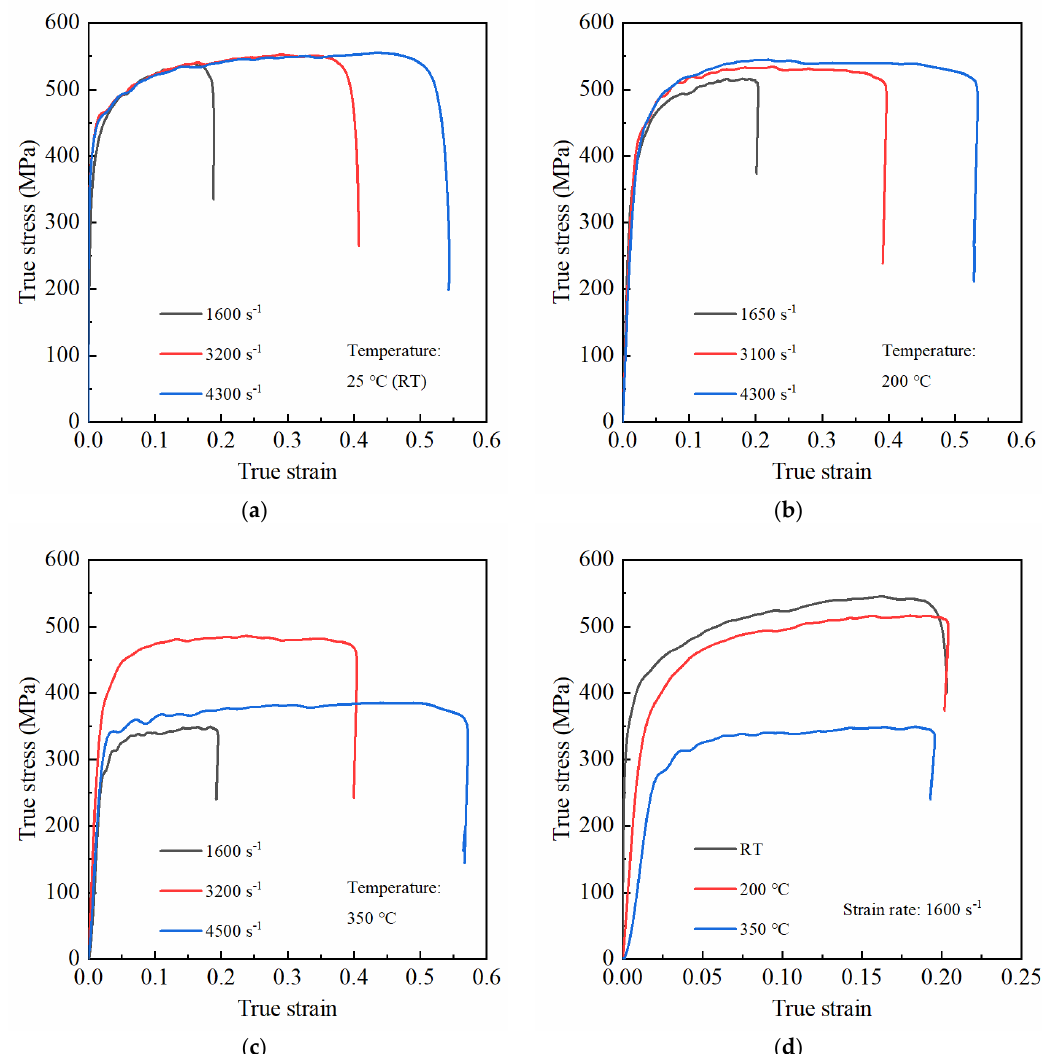
Figure 7. Influence of the strain rate and temperature on the stress–strain curves of PRMMCs. ( a ) True stress–strain curves at RT; ( b ) true stress–strain curves at 200 °C; ( c ) true stress–strain curves at 350 °C; ( d ) true stress–strain curves at 1600 s −1 .